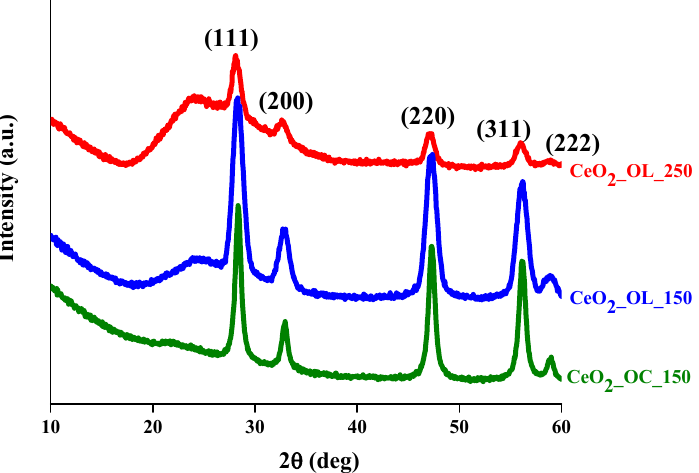
Figure 2. XRD patterns of CeO 2 _OC_150 (green), CeO 2 _OL_150 (blue) and CeO 2 _OL_250 (red).